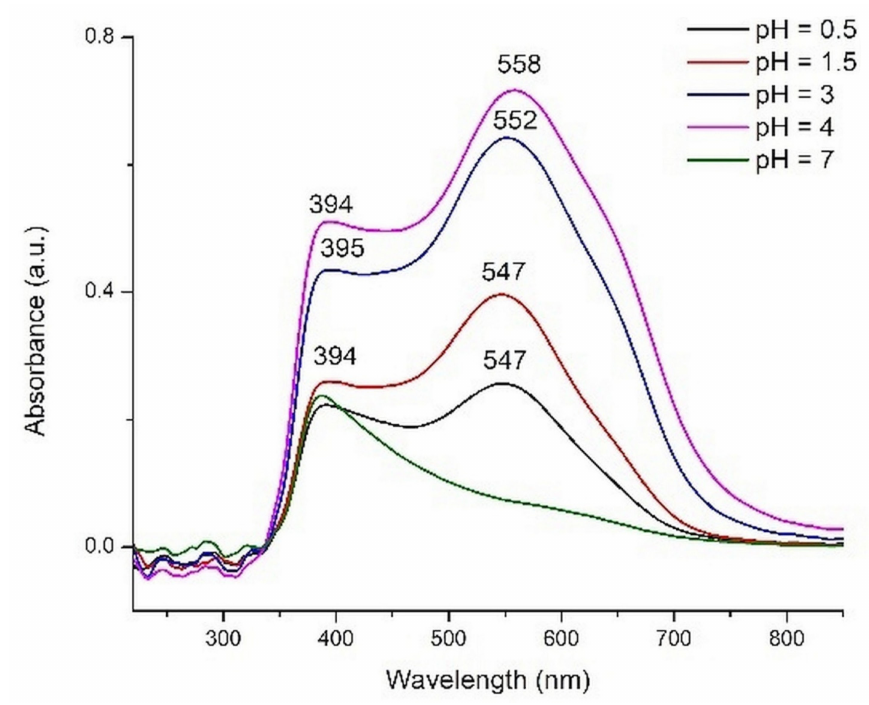
Figure 10. The UV-Vis spectra of the pigments adsorbed onto sensitized TiO 2 layers. As a general observation, the band characteristic to anthocyanins is shifted to higher wavelengths for all extracts. This shifting has as effect a change of the plates color com- pared to the corresponding extract and is due to the interaction with TiO 2 . The pigments molecules can be coordinated to Ti(IV) or the color can be changed due to the basic character of the